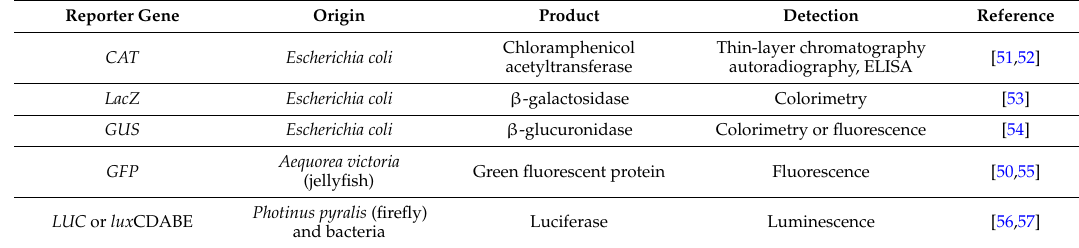
Photinus pyralis (firefly) and bacteria ELISA: enzyme-linked immunosorbent